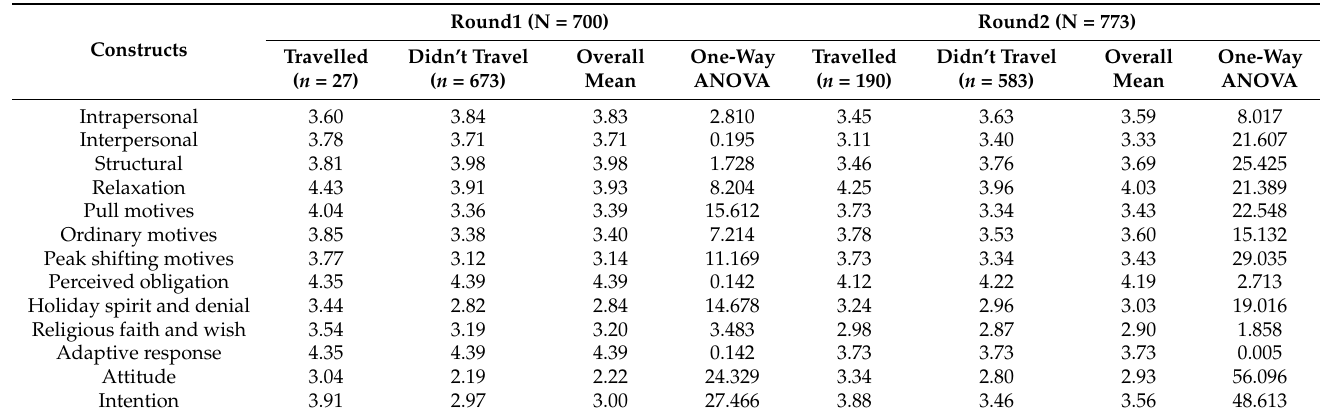
Table 3. Comparison between those who travelled and who didn’t.